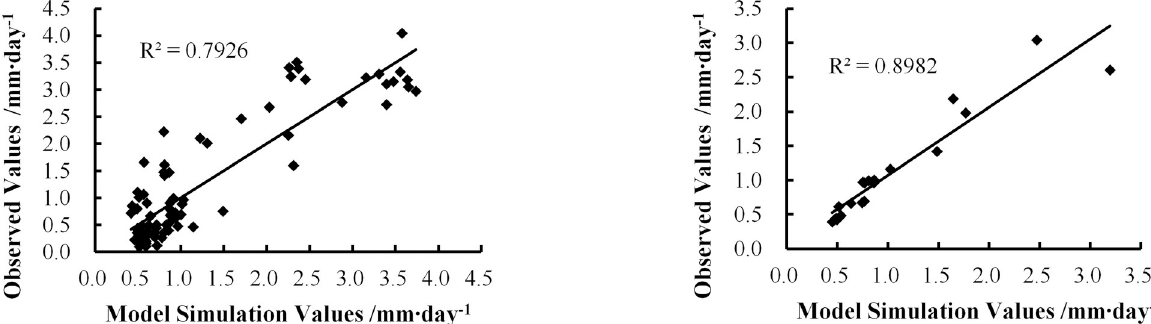
Fig 3. Comparison between the estimated and observed daily evapotranspiration values of the vegetation communities: (a) 82 sets of modeling data and (b) 20 sets of verification data.